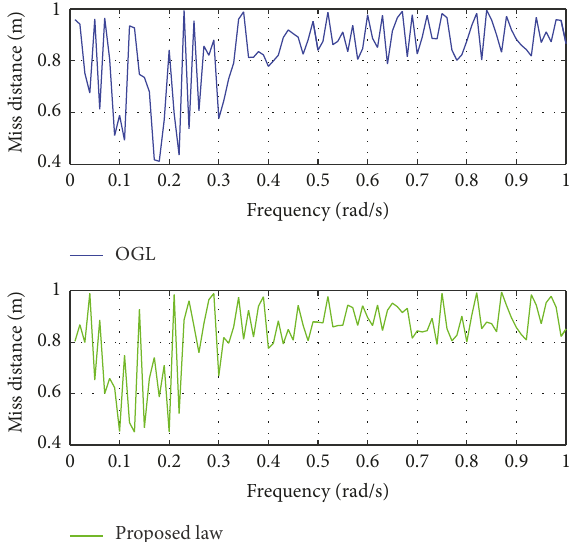
Figure 17: Final miss distance of OGL and proposed law under different sinusoidal acceleration of